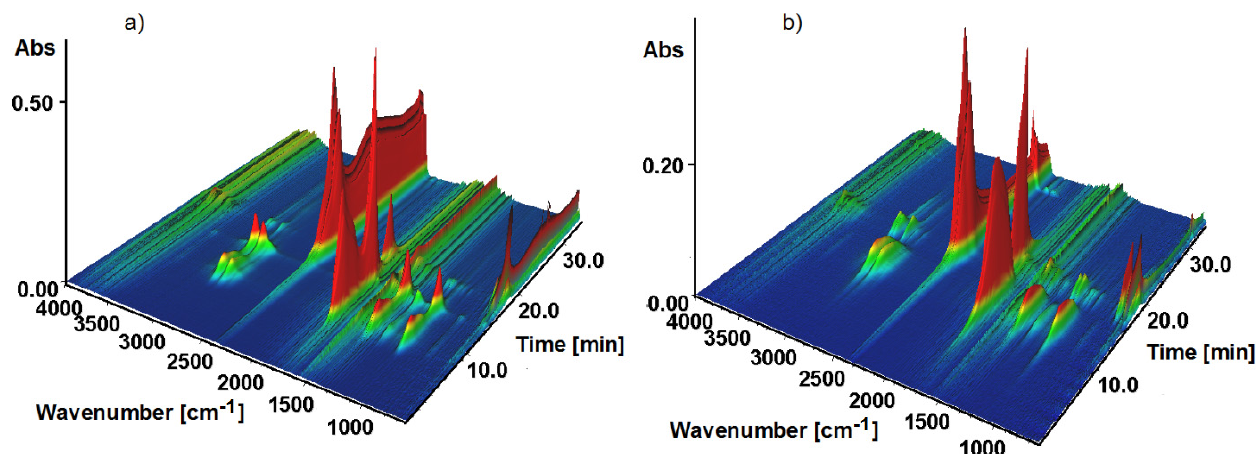
Figure 7. ( a ) Stacked plot of FTIR spectra of the evolved gases for 2 . ( b ) Stacked plot of FTIR spectra of the evolved gases for 6 .